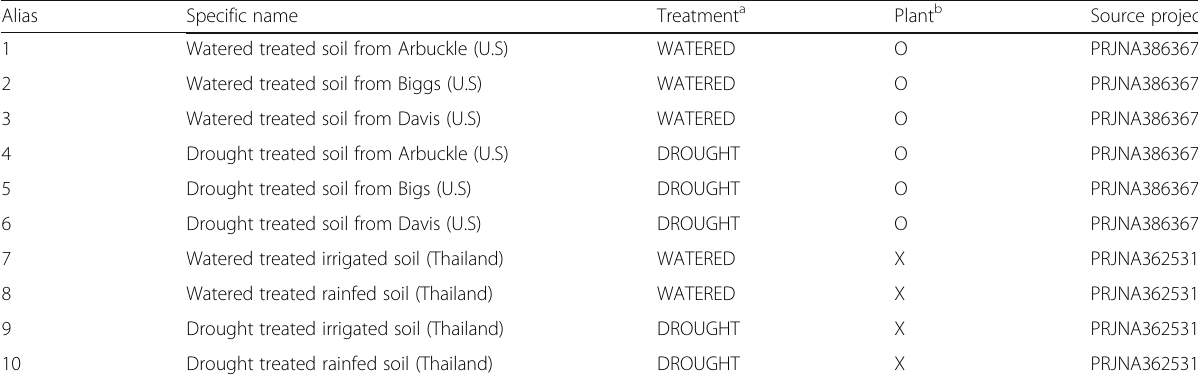
Table 1 Detailed information for the samples used to make Fig. 2 and Fig. 3